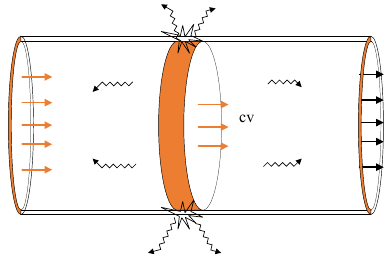
Figure 4. The friction loss of the pipe.